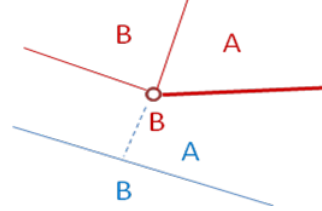
Figure 4. Linked node and adjacent segments. The similarity indicator determines the best matching segment (bold), which links the B-A segment in the blue dataset with a B-A segment in the red one.